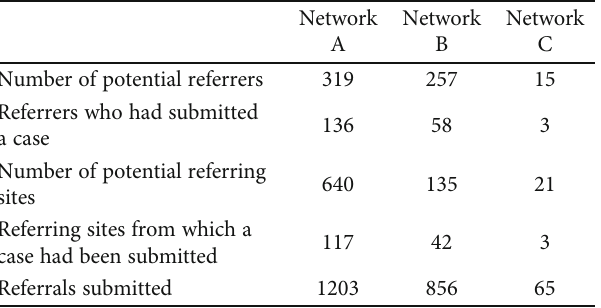
Table 3: Network demand during the fi rst six months of 2020.